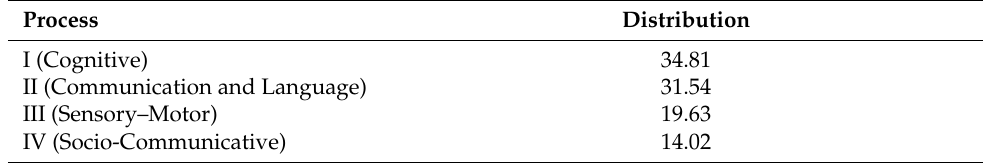
Table 4. Distribution of all the cases classified by the different